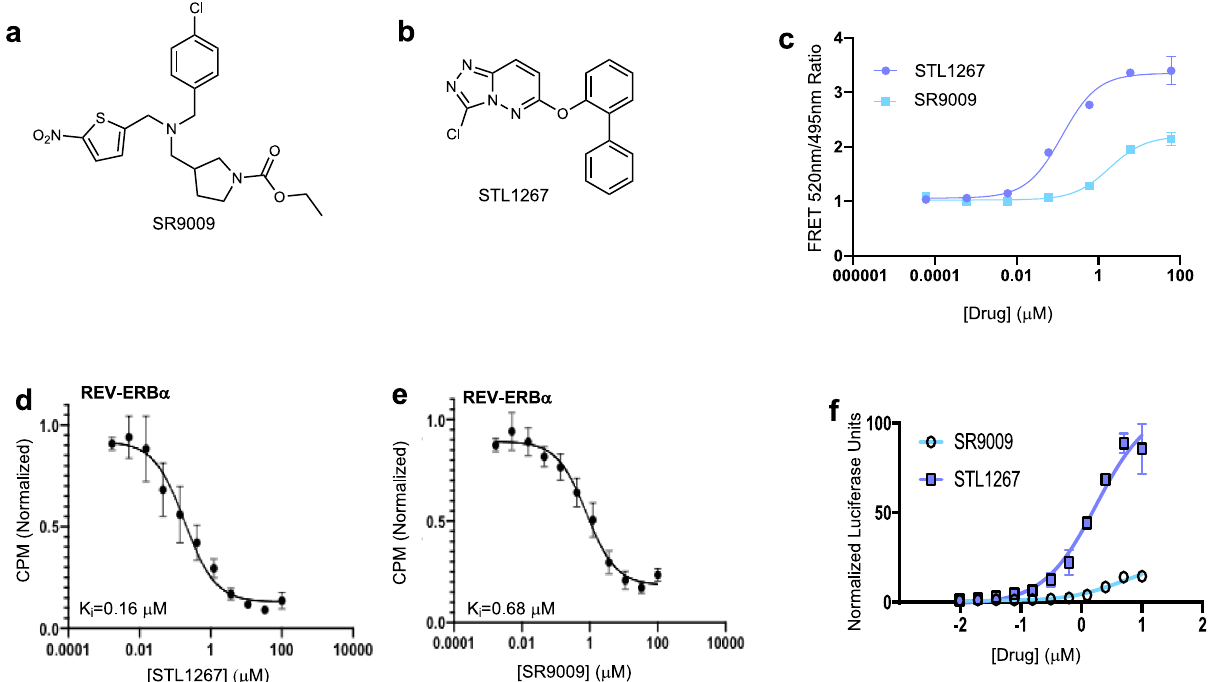
Fig. 1 | STL1267 binds to REV-ERB, resulting the recruitment of NCoR and regulationofdownstreamtargetgenes. Structures of SR9009 ( a ) and STL1267 ( b ). c FRET assay demonstrating NCoR ID1 recruitment to REV-ERB α in the presence of STL1267 ( λ ; blue) or SR9009 ( ν ; light blue). Results of a REV-ERB α scintillation proximity radioligand binding assay illustrating displacement curves using either unlabeled STL1267 ( d ) or SR9009 ( e ) to displace 3 H-STL1267 from the REV-ERB α LBD. f Cell-based two-hybrid luciferase